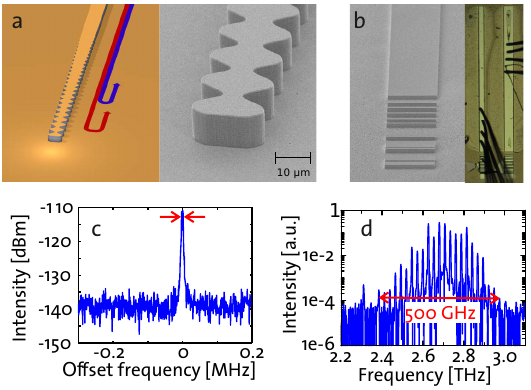
Figure 18: Double-chirped mirror architectures for THz QCLs: a Ap- proach published by the MIT group in ref. [70]: The waveguide width is varied to achieve a contrast in refractive index. Both period and amplitude are chirped to introduce anomalous dispersion over a large frequency range. The longer the corrugation length the more dispersion is added. The right figure shows an SEM picture of a fab- ricated structure from ref. [70] b Our approach, where the mirror is realized by intersecting sections of BCB and active region (MQW) to achieve a high refractive index contrast. c Beatnote and d corre- sponding optical spectrum of a DCM (ETHZ design) in CW